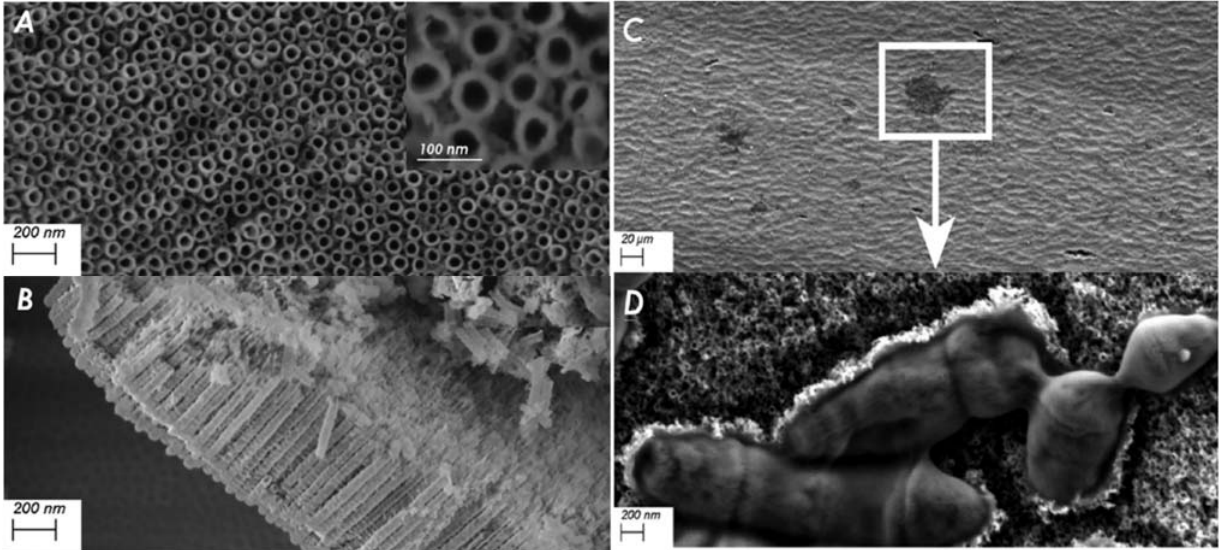
Figure 6. ( A ) Surface SEM micrographs of nanotubes at different magnifications; ( B ) cross ‐ sectional SEM micrograph of nanotubes; ( C ) surface SEM micrograph of bacteria adhered to nanotubes without biopolymer coatings; ( D ) high ‐ magnification micrograph showing that adherent bacteria on the non ‐ functionalized nanotubes caused damage to the nanotube layer. Reproduced and adapted from [183] under Creative Commons Attribution 4.0 International License (CC BY 4.0).